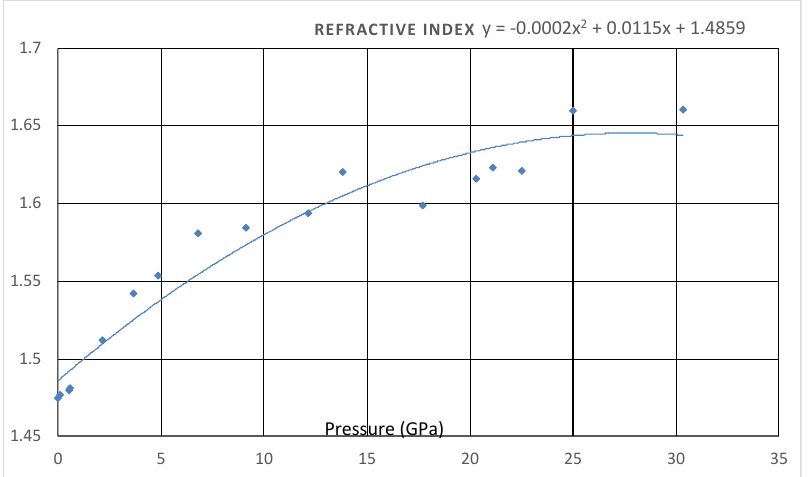
y = -0.0002x 2 + 0.0115x + 1.4859